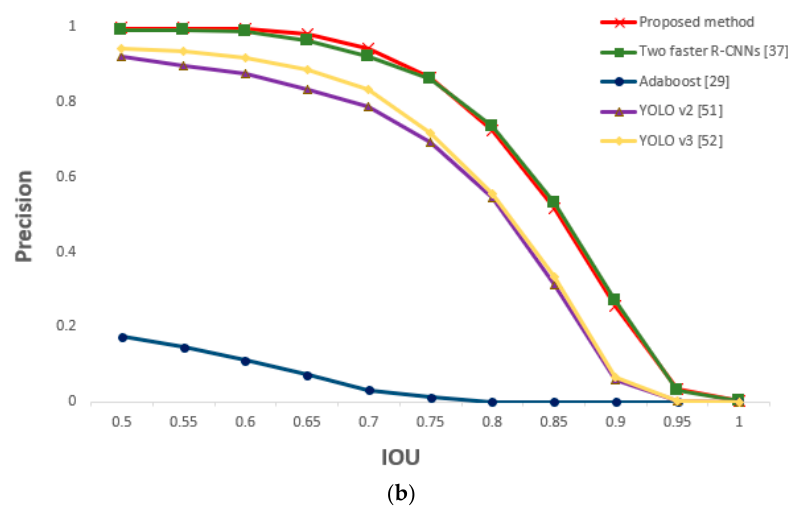
Figure 21. Comparative graphs of ( a ) recall and ( b ) precision of the proposed and previous methods according to IOU thresholds.